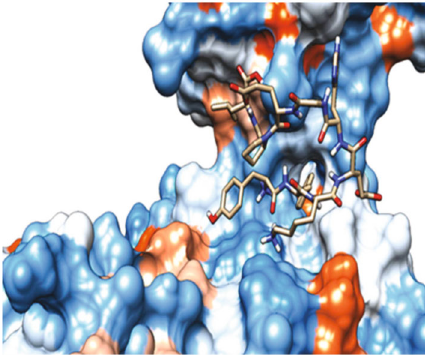
Figure 19: Illustration of the 3D interaction of the best docking poses of YFKEHGEPL in the binding sites of HLA-A ∗ 02:06.